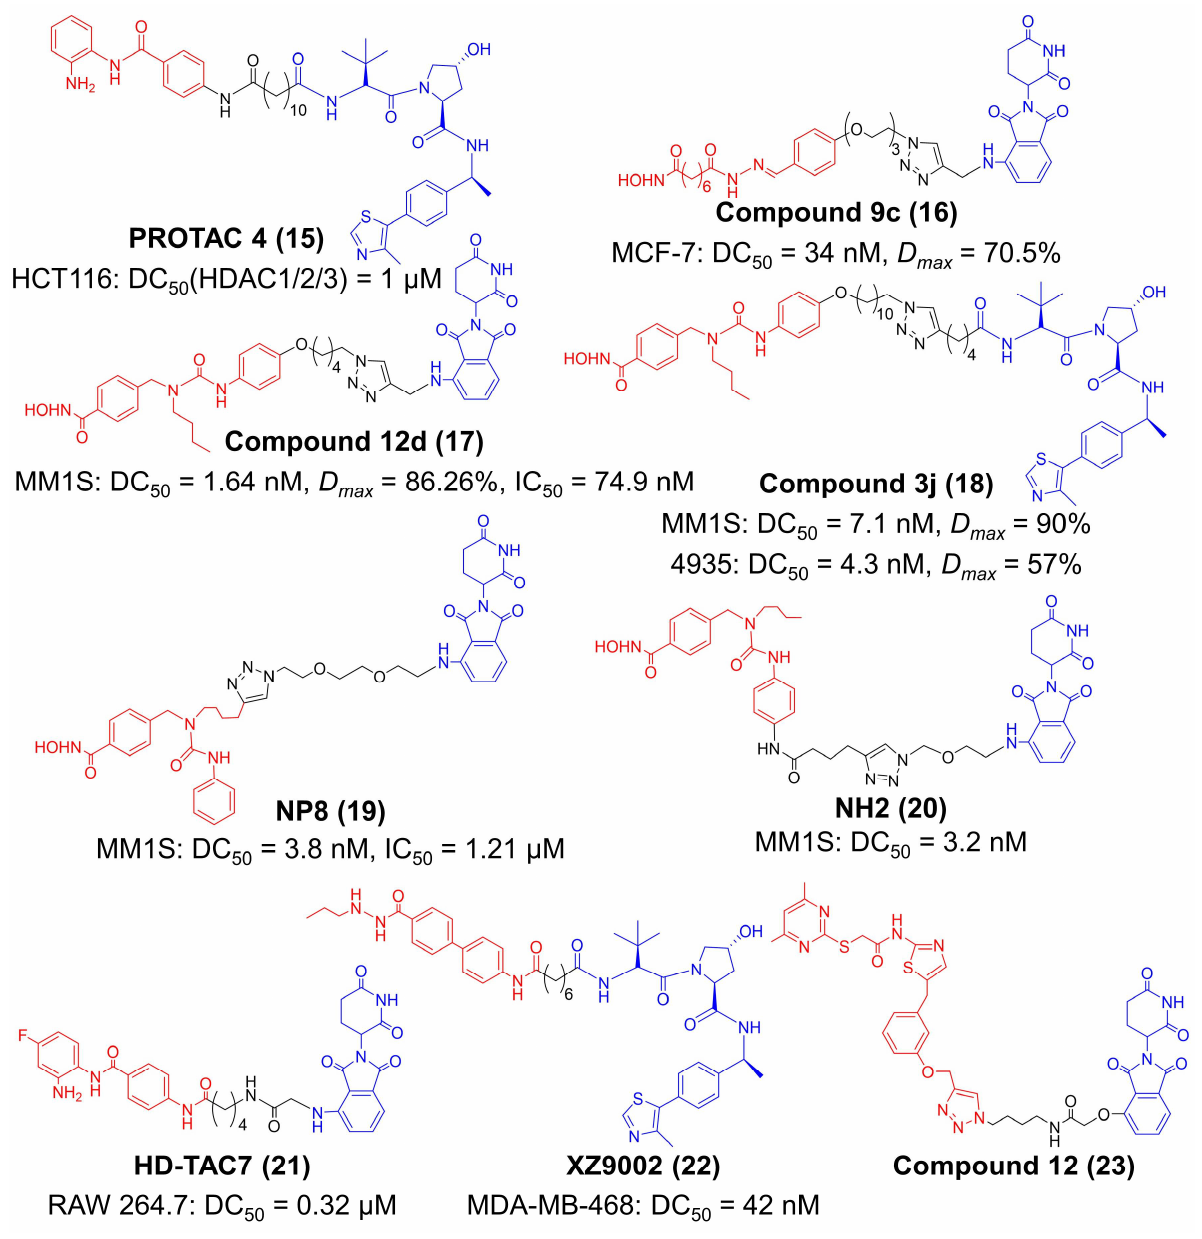
Figure 4. The chemical structures of representative PROTACs targeting HDAC. DC 50 —half-maximal degradation concentration; Dmax —maximum degradation; IC 50 —half-maximal inhibition concentration.